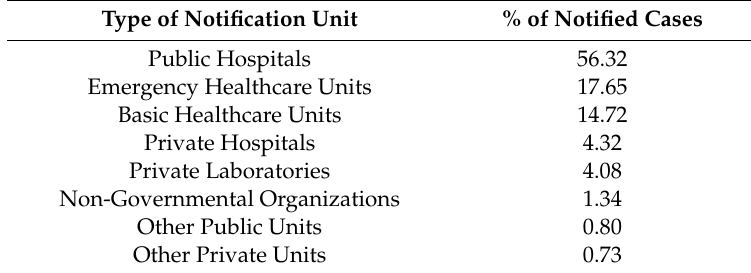
Table 2. Notified dengue cases between 2015 and 2019, per type of notification unit. Data source: Sistema de Informaç ã o de Agravos de Notificaç ã o